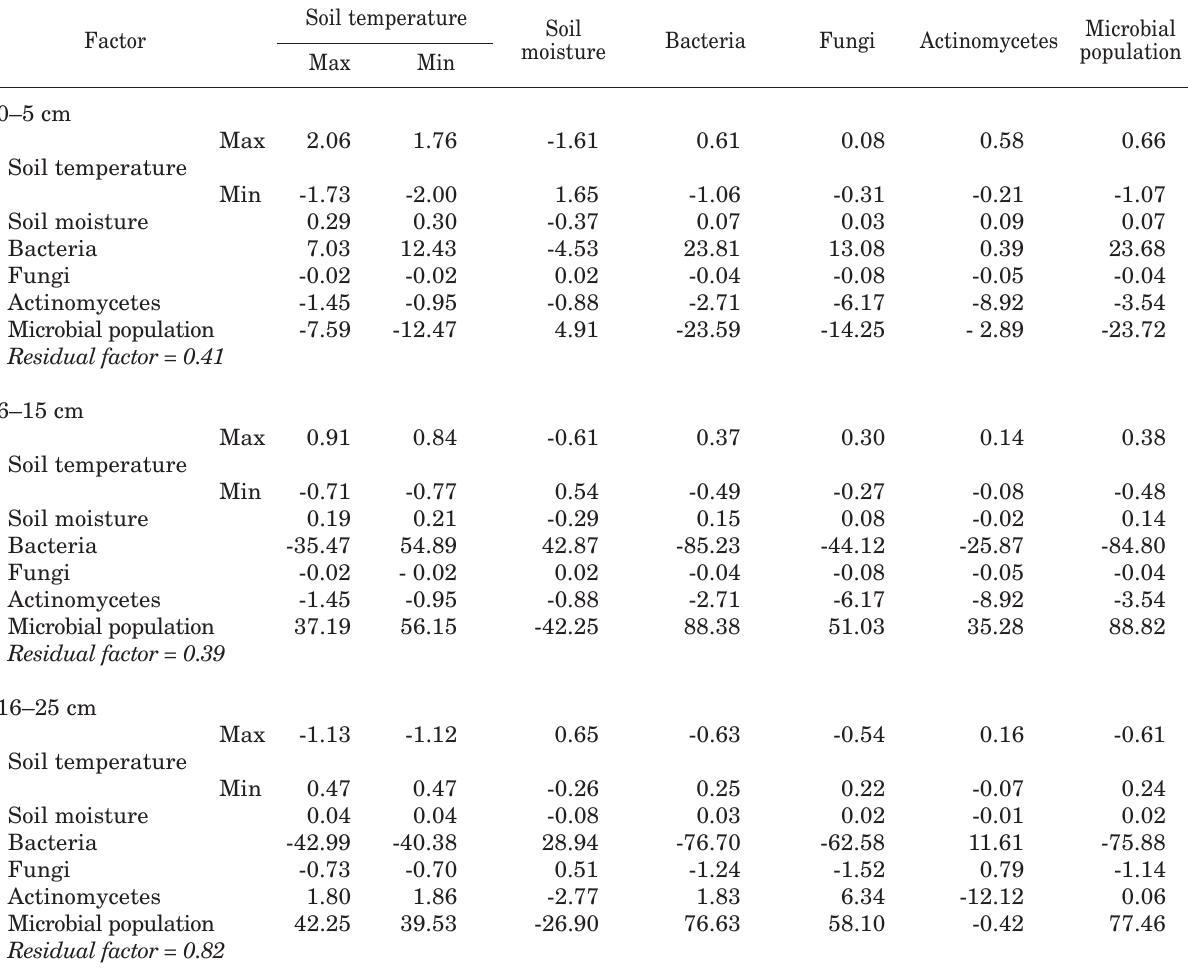
Table 1. Direct and indirect effects of certain factors influencing Fusarium oxysporum f. sp. cumini populations at different soil depths in fields planted with